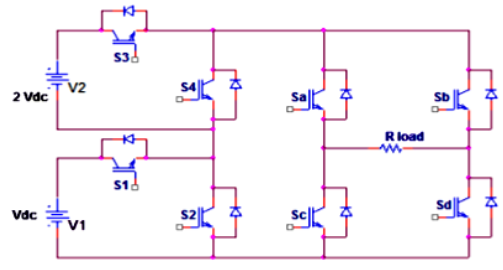
Electronics 2020 , 9 , x FOR PEER REVIEW